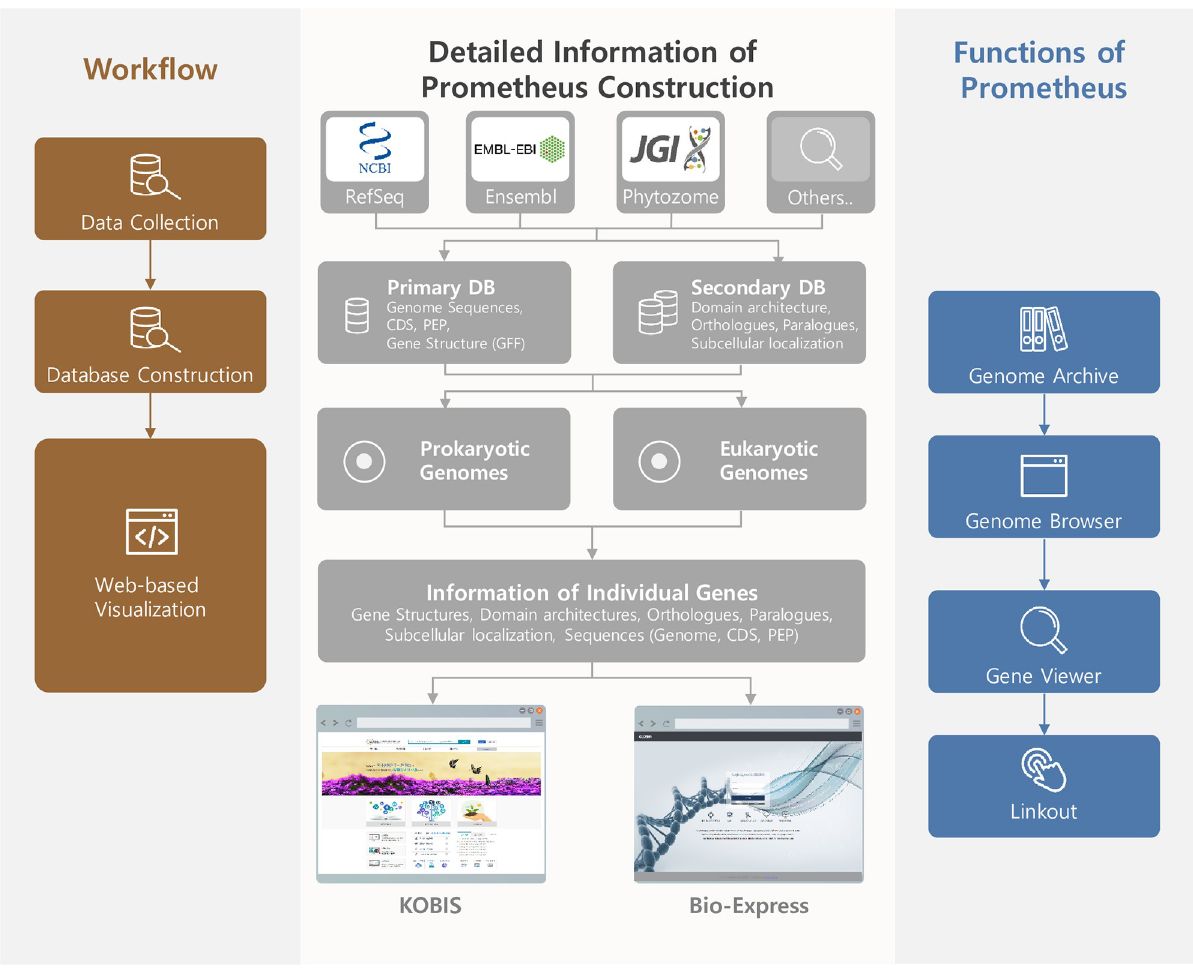
Fig 1. Concept and construction progress of Prometheus. Schematic showing the workflow for constructing Prometheus (left), detailed information for each stage (middle), and the functions available within Prometheus (right).